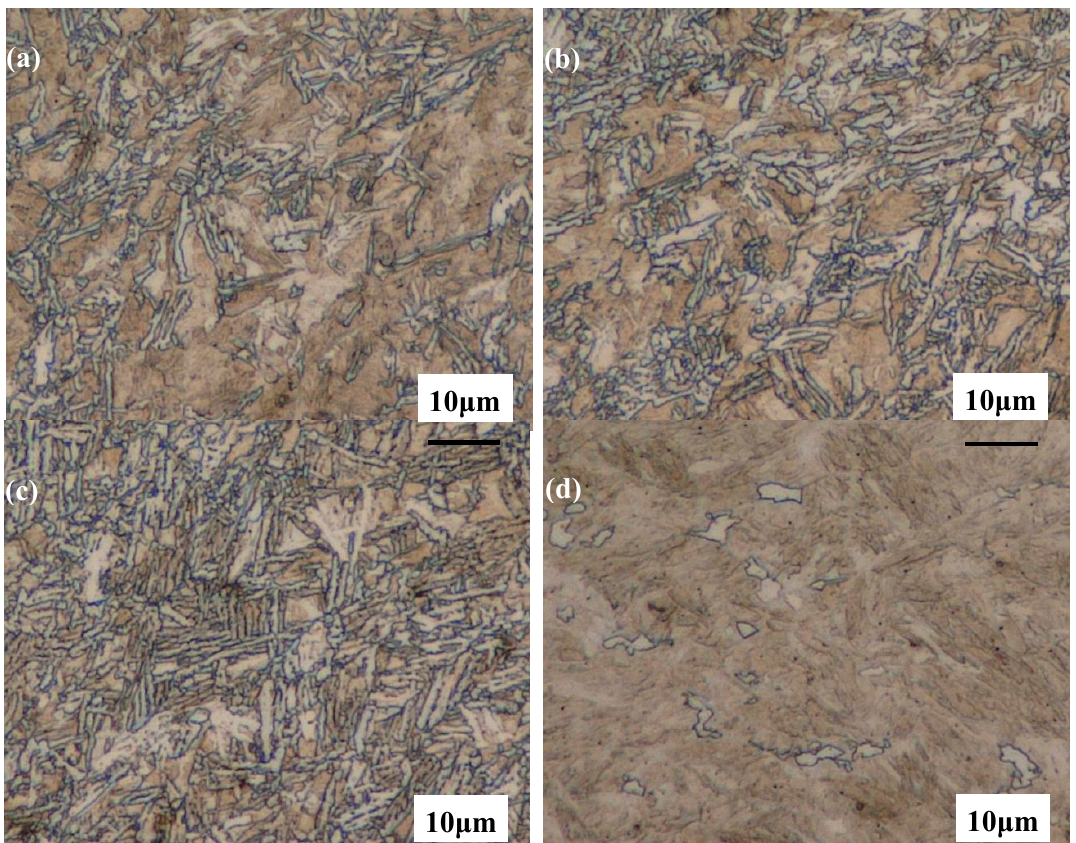
Figure 3. Microstructures of the test steel with di ff erent technology; ( a ) The partitioning time is 10 s with quenching and partitioning (Q&P) processing; ( b ) The partitioning time is 60 s with Q&P processing; ( c ) The partitioning time is 120 s with Q&P processing; ( d ) The relaxation time is 6 s with dual-phase (DP) processing.